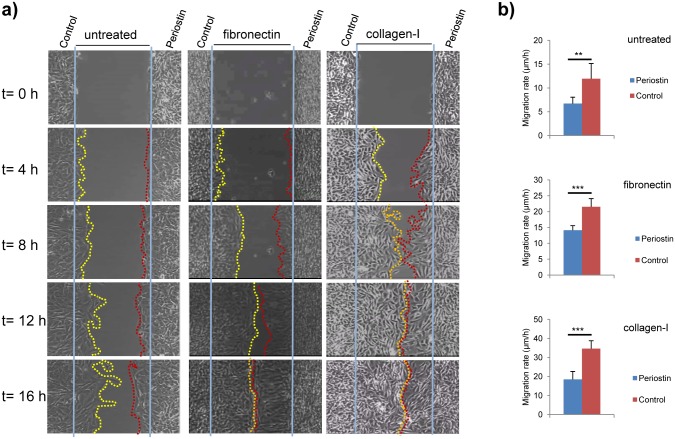
Periostin overexpressiong compromises migration properties of MC3T3-E1 cells.(a) MC3T3-E1 periostin-overexpressing (P) and control cells (C) were allowed to migrate simultaneously over a 500 μm gap in standard culture dishes commonly employed for wound healing assays (untreated) or wells coated with type-I collagen or fibronectin. Pictures at starting (t = 0 h), 4 h, 8 h, 12 h, and 16h time points are included. Starting point is indicated with a straight blue line and final points with a dotted line: yellow for MC3T3-E1 control cells and red for clone P3 cells. (b) Graphical representation of migration rate measured at 8 h from three independent experiments. Student t test (p < 0.05, *; p < 0.01, **; p < 0.005, ***).